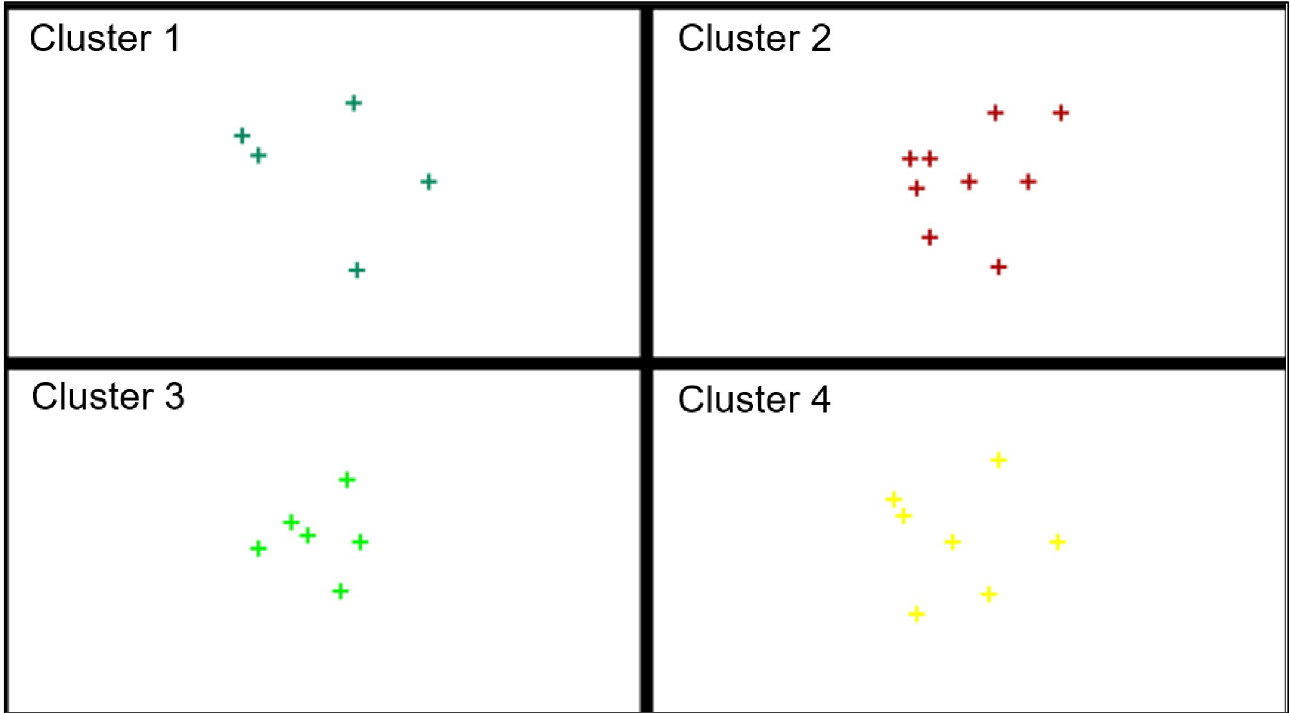
Fig 9. The topological map of similar groups of the EU-27 countries for medium-sized enterprises.